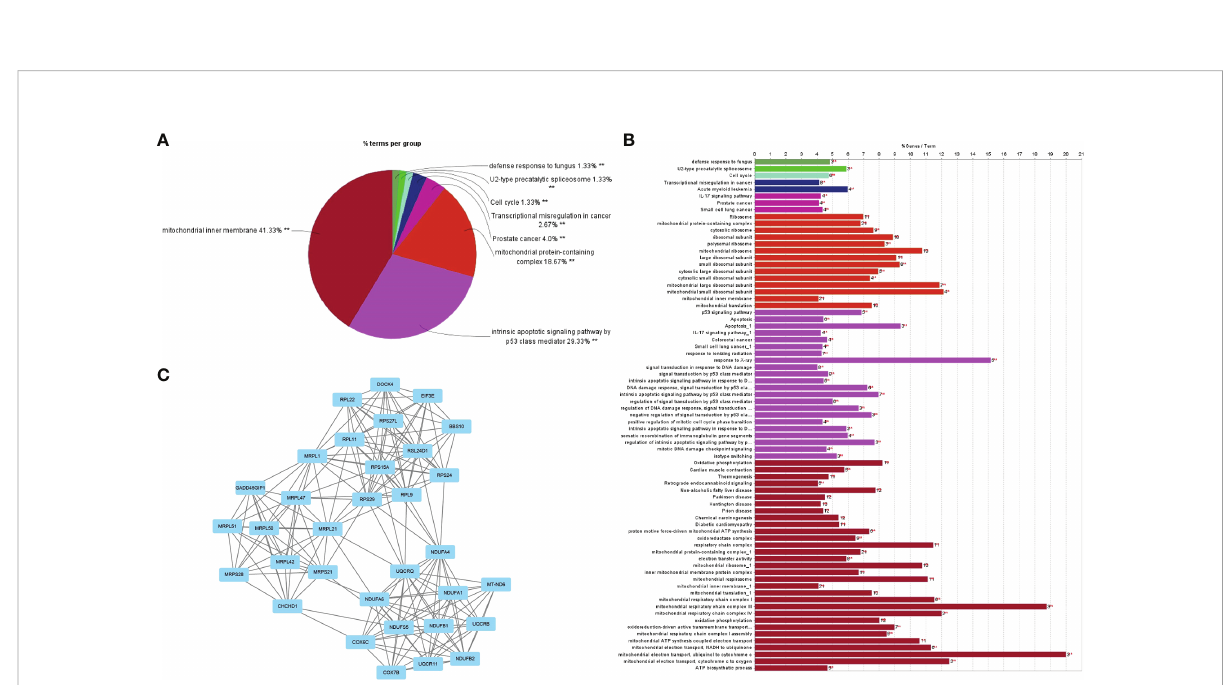
FIGURE 3 GO analysis of the shared genes in RA and DLBCL. (A) The percentage of GO terms in the shared genes, ** P < 0.01; (B) GO biological process of the four clusters; (C) PPI network of 128 most signi fi cant shared genes. RA, rheumatoid arthritis; DLBCL, diffuse large B-cell lymphoma; GO, Gene Ontology; PPI, protein-protein